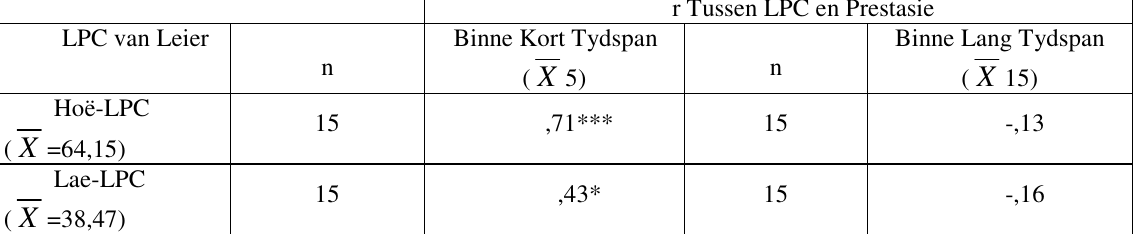
KORRELASIE TUSSEN LPC-TELLINGS EN PRESTASIE IN